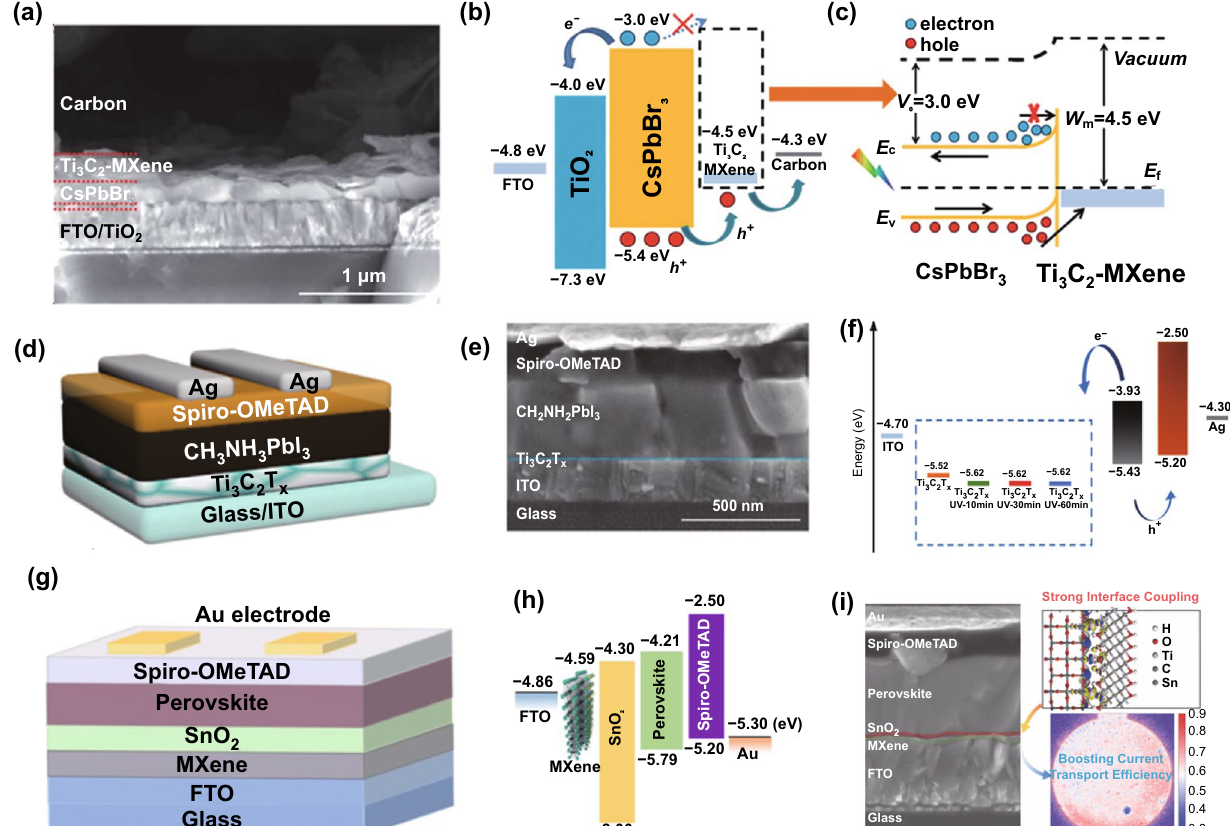
Fig. 8 CsPbBr 3 -based PSCs using the Ti 3 C 2 T x nanosheet layer as the HTL: a Cross-sectional SEM image, b energy-level alignment and c car- rier transport mechanism at illumination. Copyright © 2019 The Royal Society of Chemistry. d Device architecture and e cross-sectional SEM image, f energy-level alignment of each layer. Copyright © 2019 WILEY ‐ VCH Verlag GmbH & Co. KGaA, Weinheim. g Device configuration and h energy-level alignment of the device. i Cross-sectional SEM image of the device (left), first-principle optimized structures and electron density differences for SnO 2 /Ti 3 C 2 (OH) 2 (upper right), and spatially resolved mapping of the current transport efficiency of the MXene-inserted device (lower right). Copyright © 2020 American Chemical